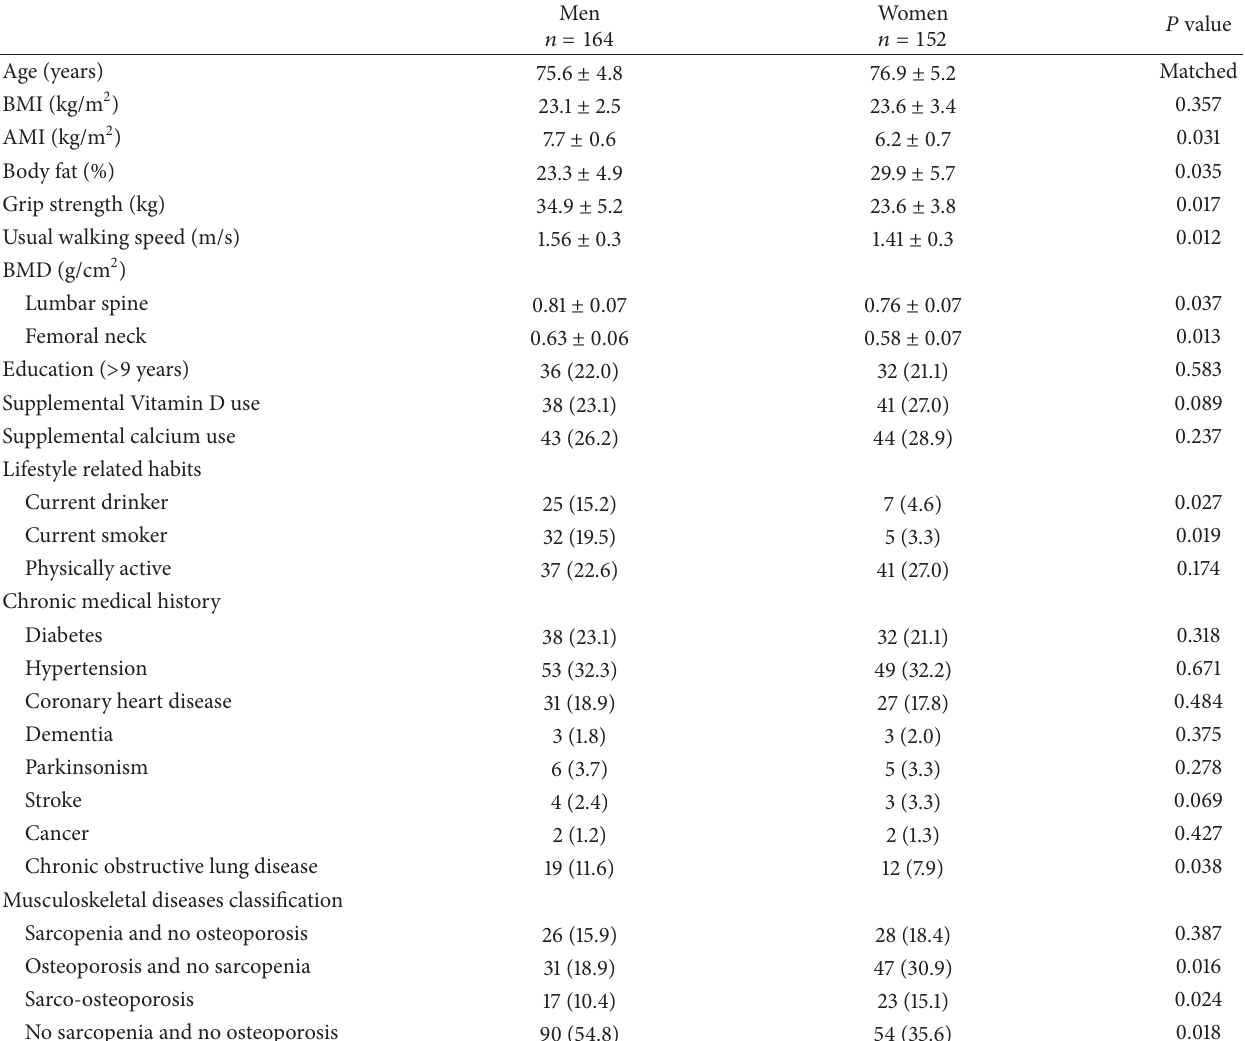
Table 1: Characteristics of the subjects by